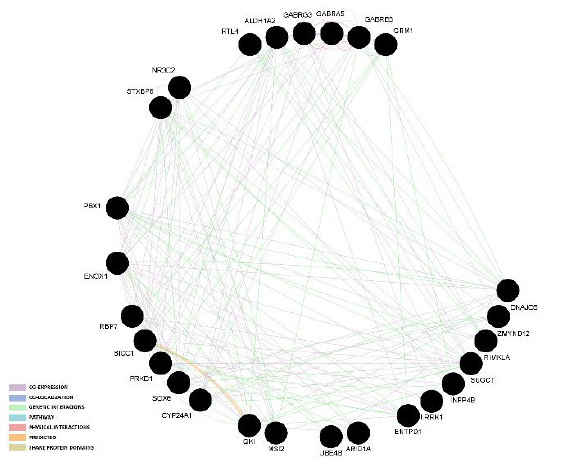
Figure 1. Gene network analysis of candidate genes that had at least two SNPs associated with re- production traits.